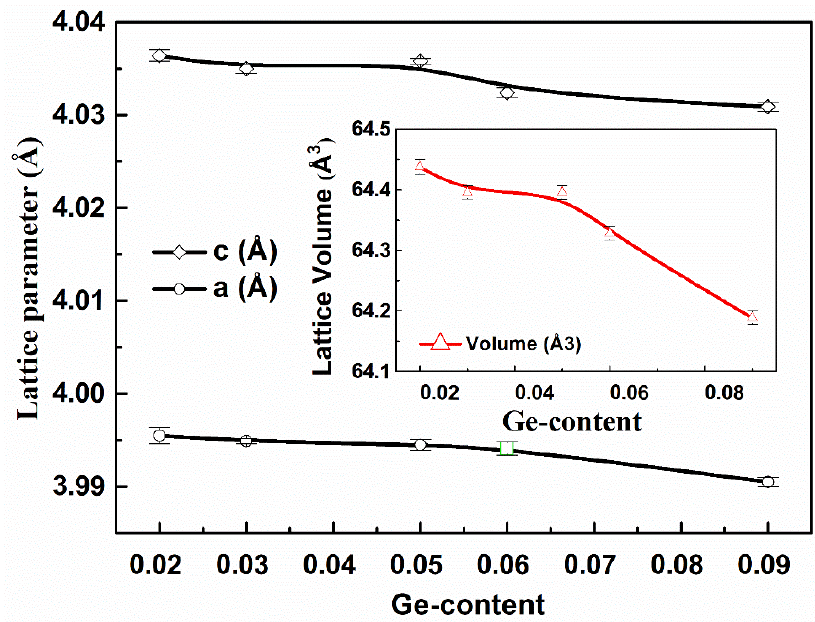
Figure 2. Lattice parameters (a and c) and volume variation of BTGx (x = 0.02, 0.03, 0.05, 0.06, 0.09) versus Ge-content. These parameters were obtained from Rietveld structural resolution using FullProf software.